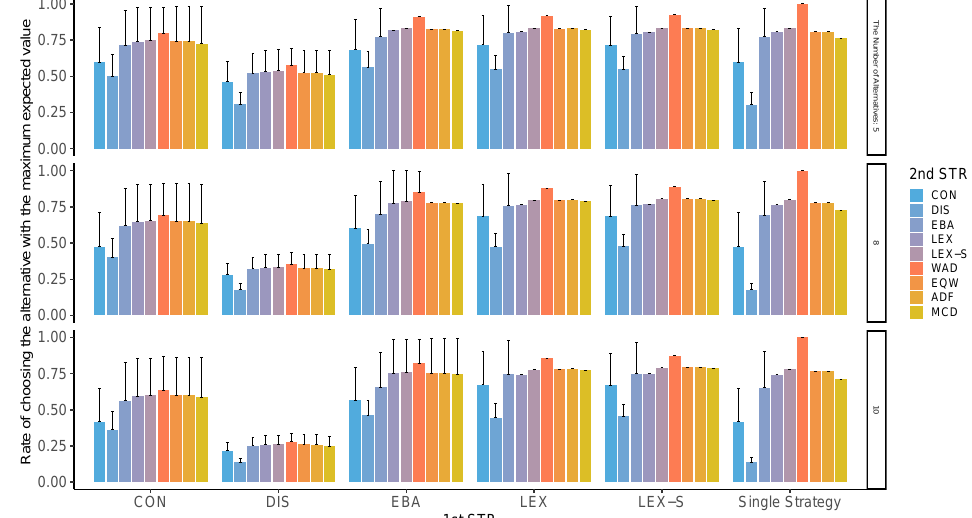
Figure A13. Best-choice rate in two-stage decision-making when only two alternatives are left in the second stage. Note: ADF: additive difference; CON: conjunctive; DIS: disjunctive; EBA: elimination by aspects; EQW: equal-weighted strategy; LEX: lexicographic; LEX-S: lexicographic semi-order; MCD: majority of confirming dimensions; STR: strategy; WAD: weighted additive.